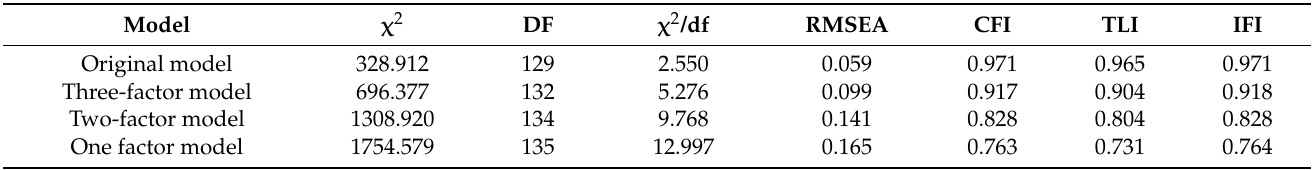
Table 8. Four-dimensional confirmatory result analysis of involution.